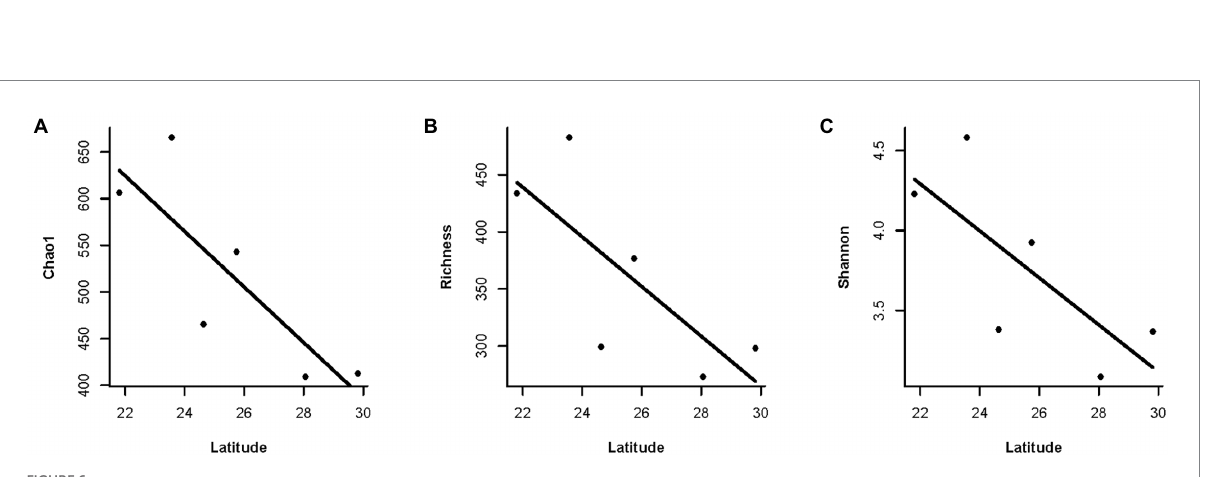
FIGURE 6 The relationship between latitude and gut microbial diversity along the eastern coast of mainland China. (A) Chao1 index. (B) Richness index. (C) Shannon